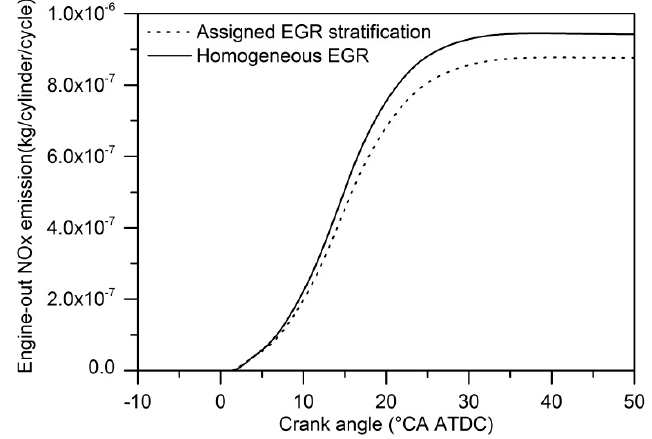
Figure 9. Comparison of engine-out NO x history between uniform EGR and assigned EGR stratification with equal mass of EGR in cylinder.